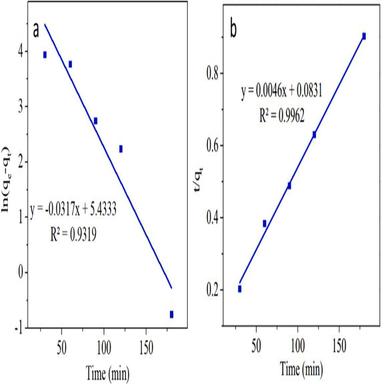
Adsorption kinetics of (a) pseudo-first-order, and (b) pseudo-second-order.